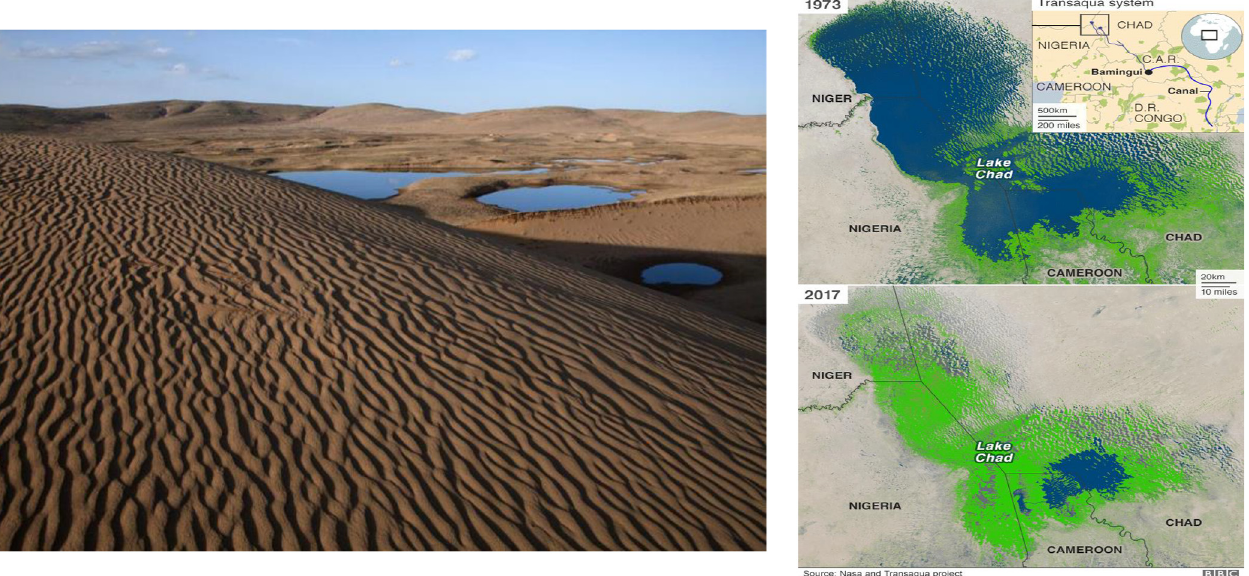
Fig. 4. Deserti fi cation in Tibet and Africa [6].